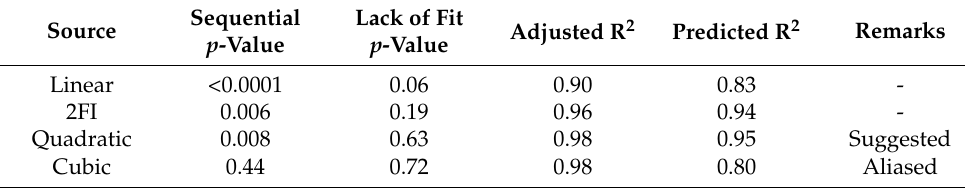
Table 3. Model summary statistics for SCCO 2 extraction of cannabis leaves.